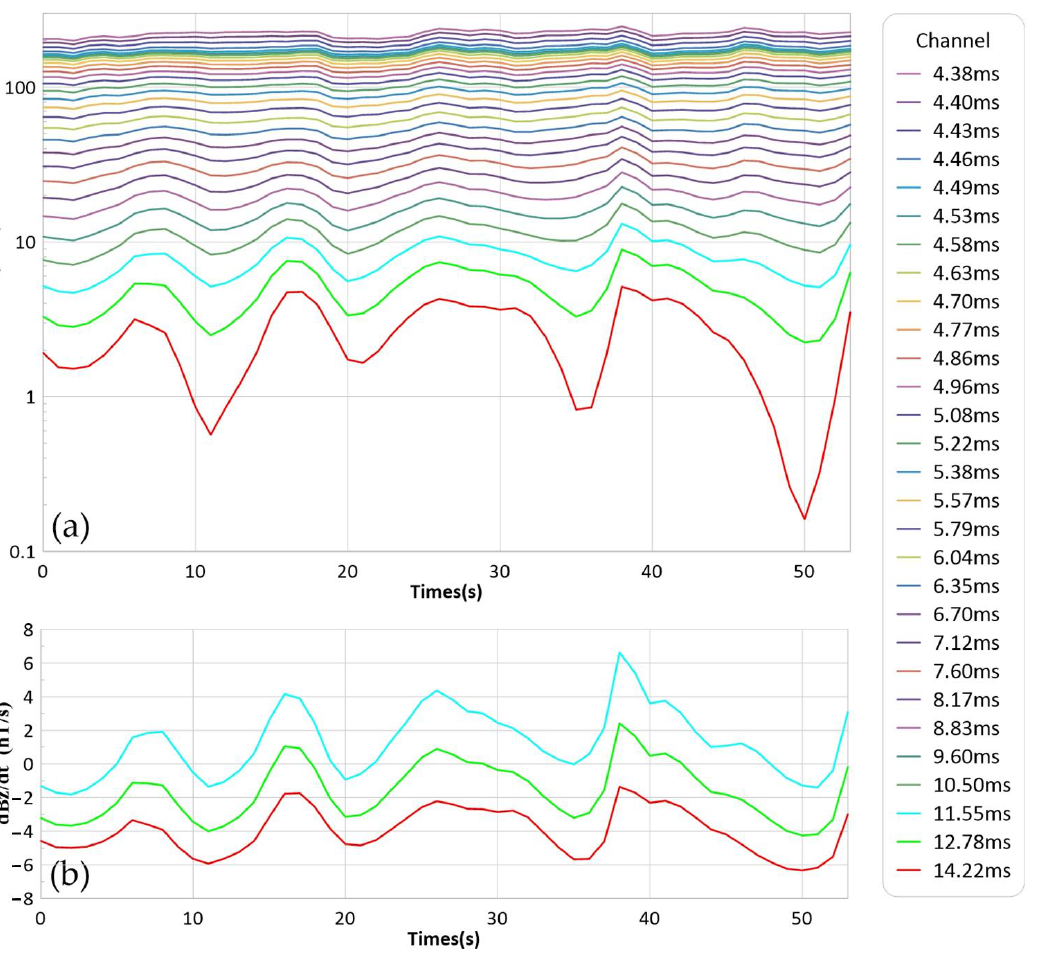
Figure 7. Noise level statistics (peak-to-peak). ( a ) Baseline data after pre-processing; ( b ) the last three late channels’ data for baseline data.